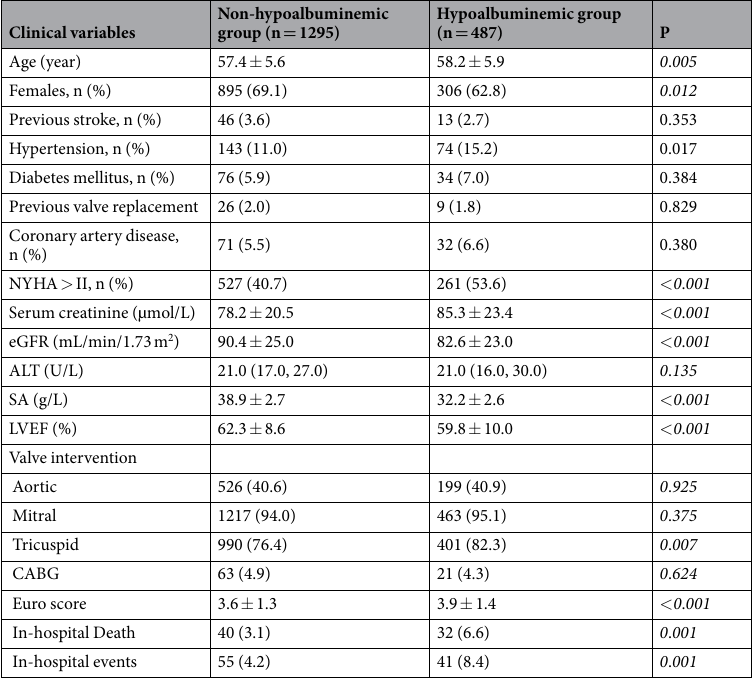
Table 1. Demographic and clinical characteristics in the two different preoperative plasma albumin groups. NYHA, New York Heart Association; eGFR, estimated glomerular filtration rate; ALT, alanine transaminase; SA, serum albumin; LVEF, left ventricular ejection fraction; CABG, coronary artery bypass